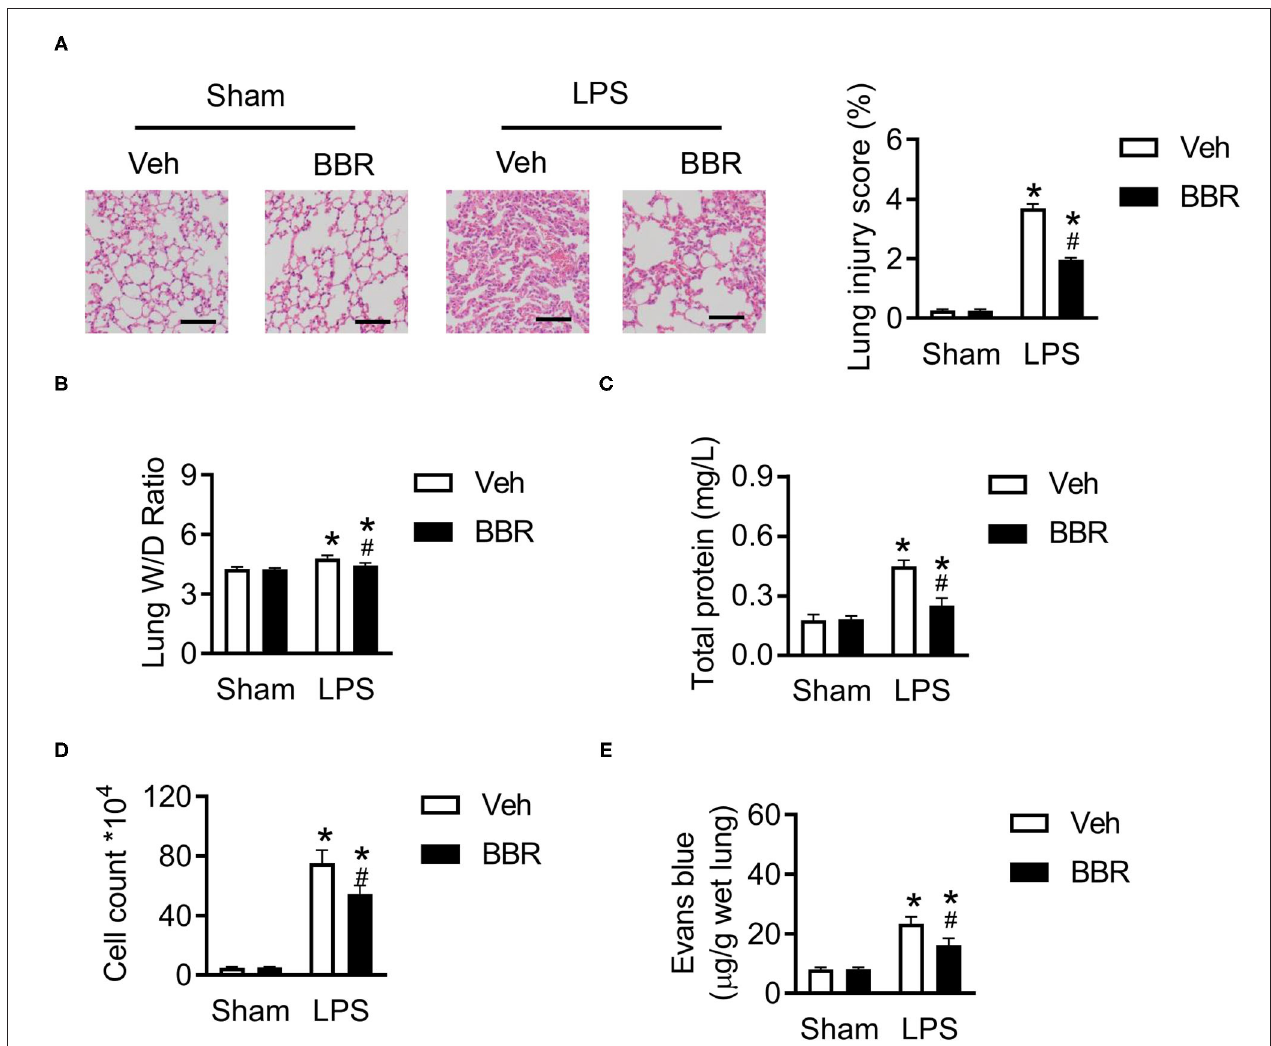
FIGURE 1 | Berberine (BBR) alleviated the permeability and lung tissue injury in C57BL/6 mice with ALI. (A) The H&E staining and lung injury score in pulmonary section, n = 3, scale bar = 100 µ m. (B) The ratio of wet lung to dry lung, n = 8. (C,D) The detection of total protein and cell counts in BALF, n = 8. (E) The concentration of Evans blue in lung tissue, n = 8. Data were expressed as mean ± SD. Statistical significance is indicated as * P < 0.05 vs. the sham + vehicle groups, # P < 0.05 vs. the lipopolysaccharide (LPS) + vehicle groups. ALI, acute injury lung; BALF, bronchoalveolar lavage